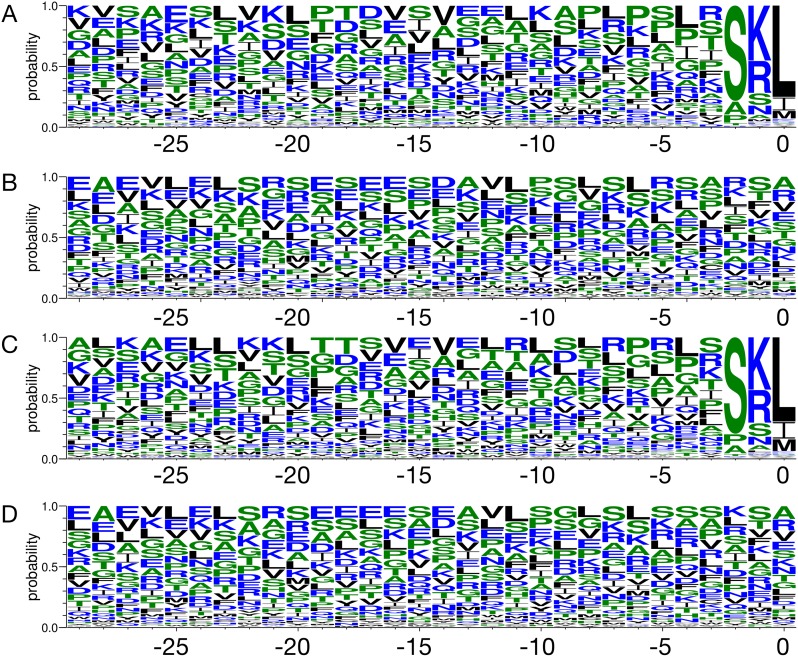
The biased amino acid composition (Aac) in each dataset.(A) peroxisomal proteins in Arabidopsis, (B) non-peroxisomal proteins in Arabidopsis, (C) peroxisomal proteins in all plants and (D) non-peroxisomal proteins in all plants. The height of each alphabet represents the probability of the corresponding amino acid at each position. The position of the last amino acid from the C-terminus was defined as 0.